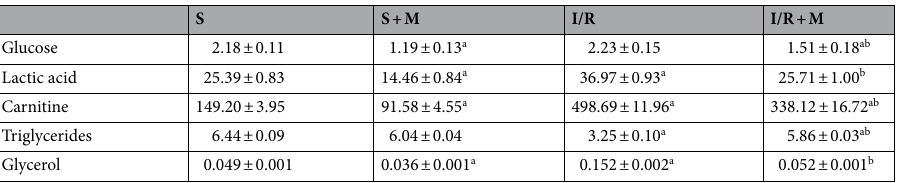
Table 1. Liver carnitine (μg/g wet tissue mass), and glucose, lactic acid, triglycerides, and glycerol concentration (μg/mg wet tissue mass). Experimental group abbreviations: S sham-operated rat group, S + M sham-operated + meldonium rat group, I/R ischemia/reperfusion rat group, I/R + M ischemia/ reperfusion + meldonium rat group. The number of animals per experimental group: n = 8. The data are given as mean ± standard error of the mean. Minimal significant level: p < 0.05. Significantly different: a in respect to S group; b in respect to I/R